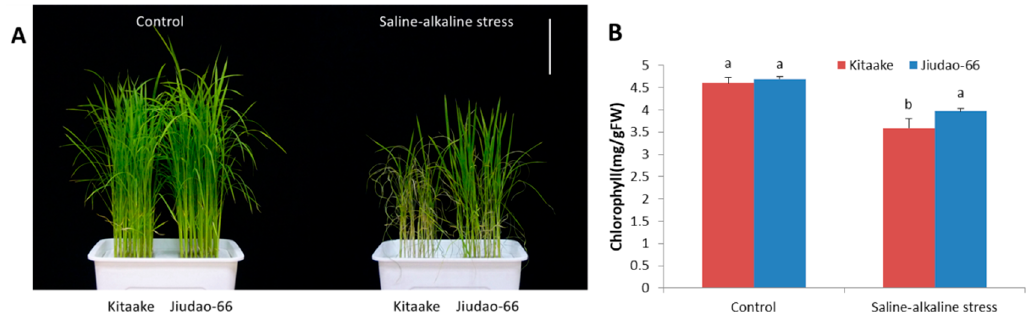
Figure 2. Effects of saline–alkaline stress on Kitaake and Jiudao-66 seedlings. ( A ) Seedling performance. ( B ) Foliar chlorophyll concentration. Twenty-five-day-old rice seedlings grown in normal culture solution were transferred to a quarter of saline–alkaline soil leachate for 24 h and exposed to normal culture solution for a recovery period of five days. Bar = 10 cm. Foliar chlorophyll content was measured at the end of the stress treatment. Values are expressed as means ± SD, n = 3. Different letters (a, b) indicate significant differences between Kitaake and Jiudao-66 under the same treatment, as determined by a Student’s t -test ( p <